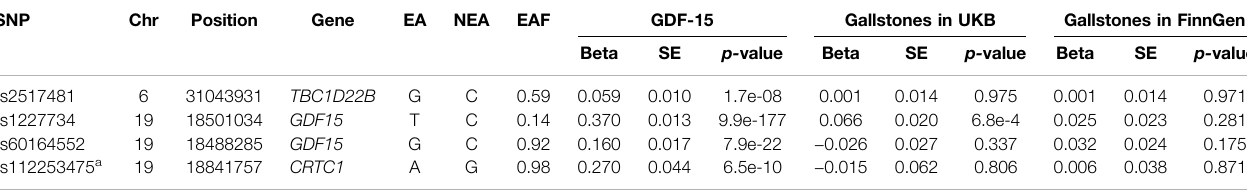
TABLE 1 | Genetic instruments for growth differentiation factor 15 levels and their associations with